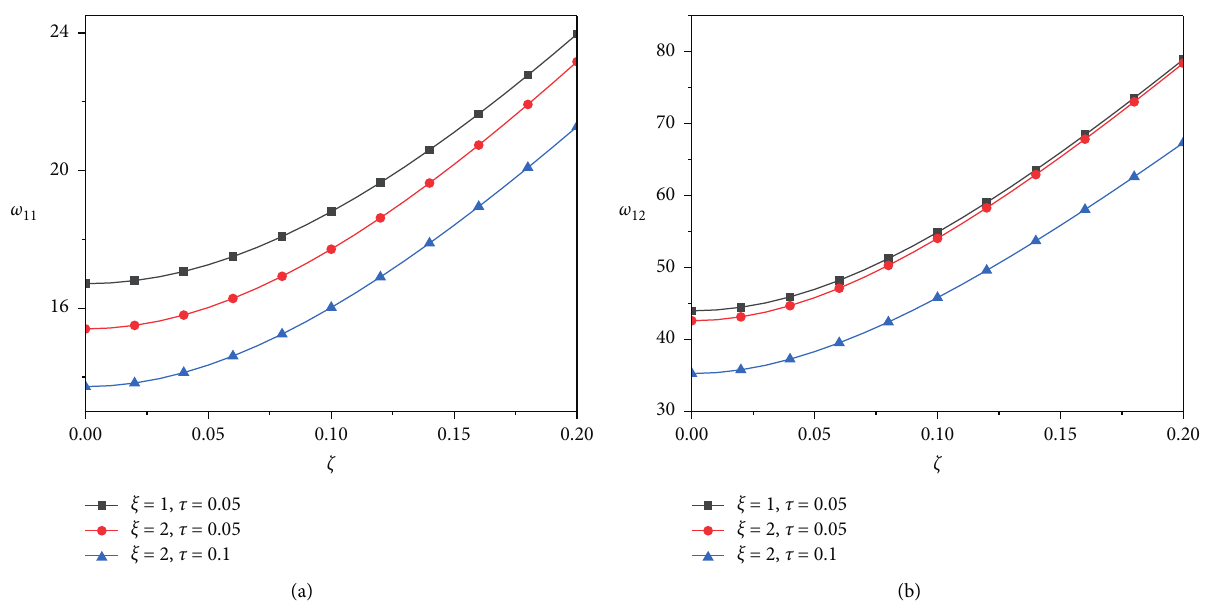
Figure 10: Variation of the vibration frequency with respect to the material characteristic scale parameter. (a) The first-order vibration frequency. (b) The second-order vibration